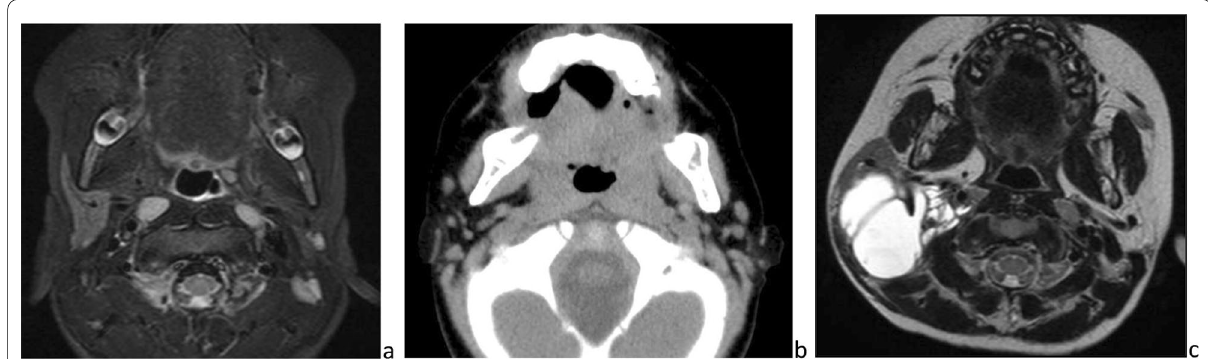
Fig. 12 Parotid gland aplasia. Unilateral, isolated aplasia on axial fat sat T 2 ‑weighted image ( a ). Bilateral aplasia on axial CT image, in Treacher‑Collins syndrome ( b ). Right parotid gland aplasia associated with contralateral macrocystic lymphangioma, on axial T 2 ‑weighted image ( c